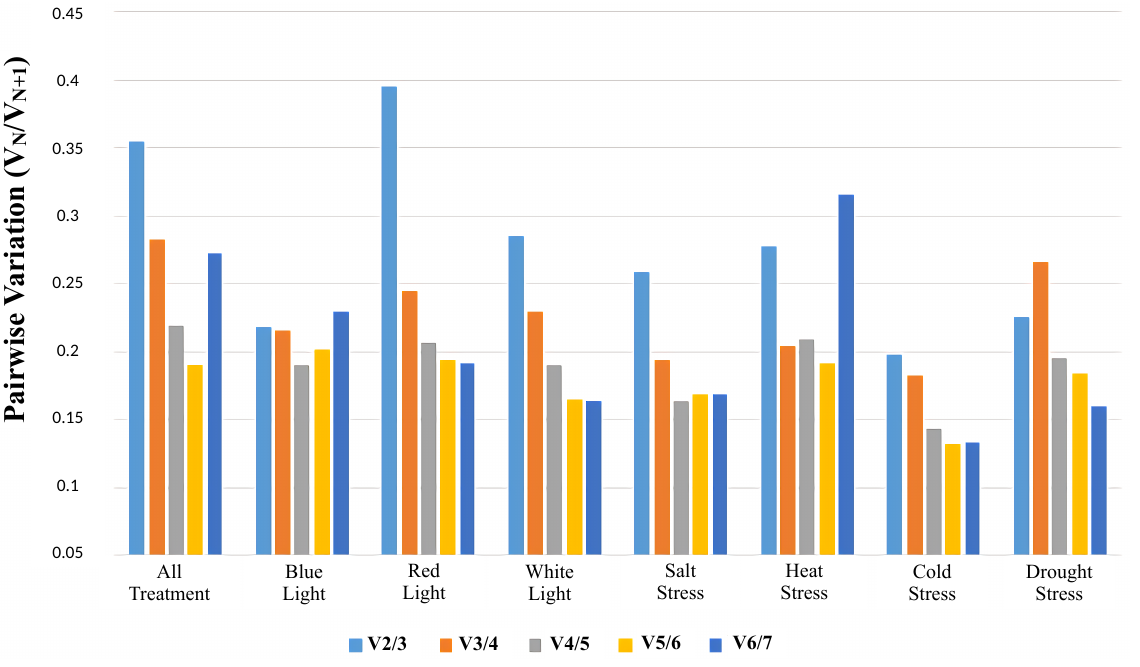
Figure 5. Pairwise variation (V N /V N+1 ) for selecting an optimal number of reference genes for data normalization under different